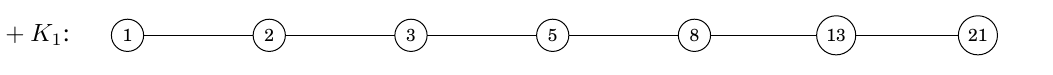
Figure 9: A positive-valued sum